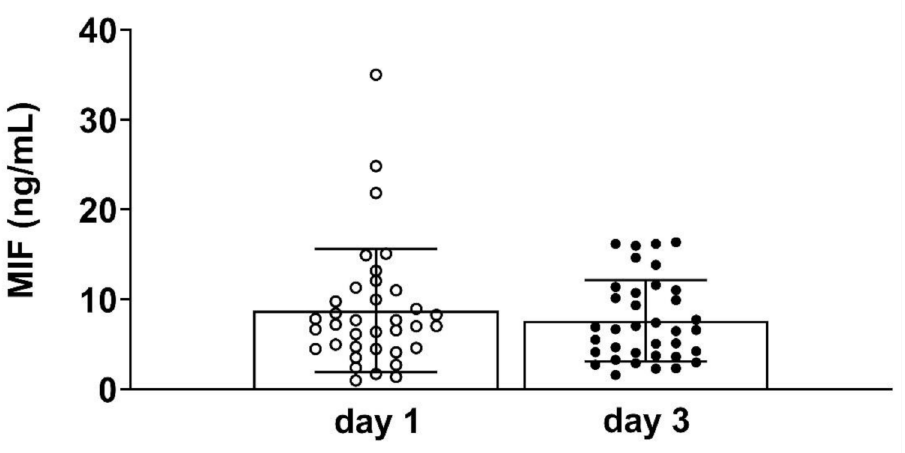
Figure 1. Plasma concentrations of macrophage migration inhibitory factor (MIF) on day 1 and day 3 of Intensive Care Unit (ICU) admission in 36 patients (day 1 vs. day 3, p = 0.307).